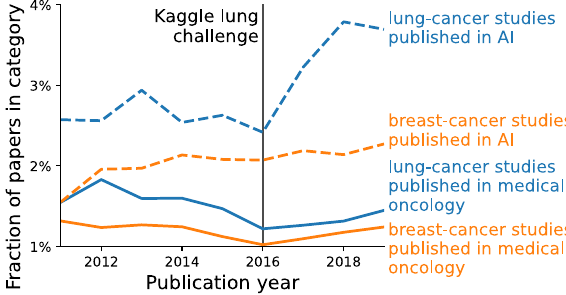
Fig. 2 Differences between relative popularity of applications. We show the percentage of papers on lung cancer (in blue) vs breast cancer (in red), relative to all papers within two fi elds: medical oncology (solid line) and AI (dotted line). Details on how the papers are selected are given in the Supplementary Information). The percentages are relatively constant, except lung cancer in AI, which shows an increase after